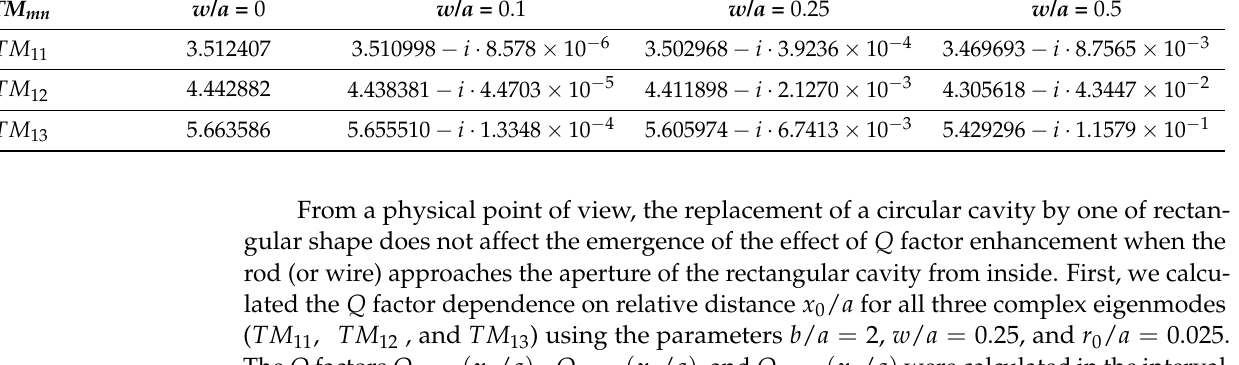
( n = 1,2,3 ) versus relative distance x (𝑛 = 1,2,3) versus relative distance 𝑥 1 n (cid:3117)(cid:3289)